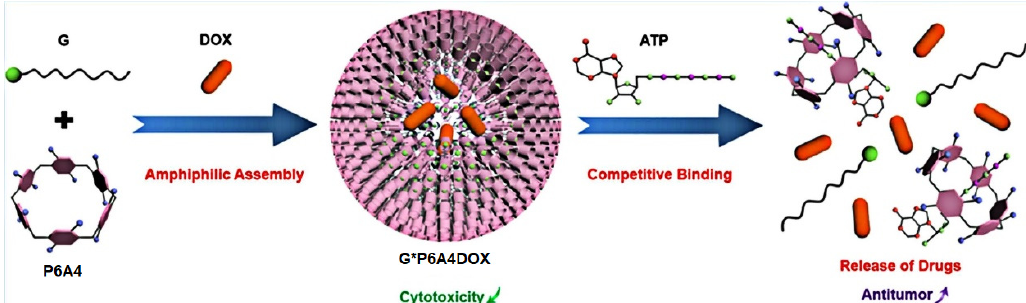
Figure 11. Schematic illustration of the fabrication of a “ G*P6A4*DOX ” drug delivery system. Re- produced with the permission of reference [87]. Copyright © American Chemical Society 2021.